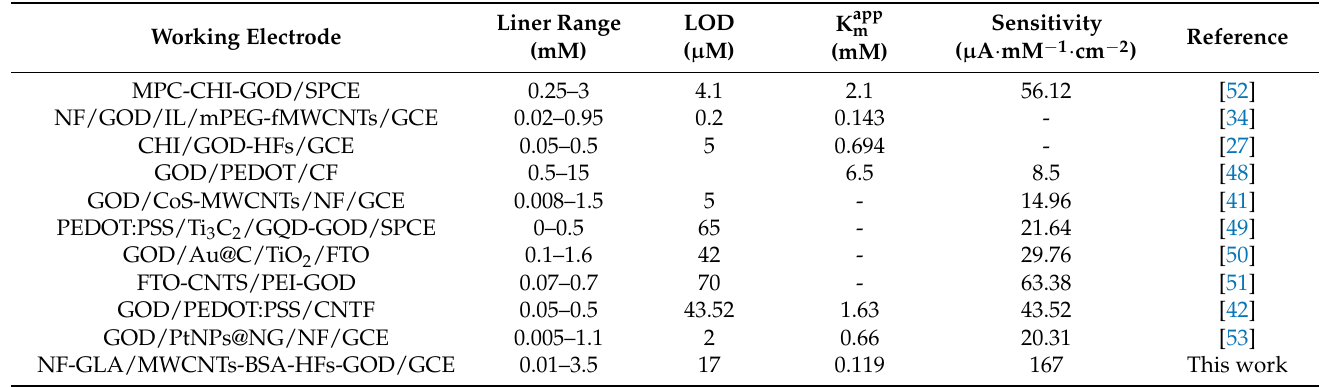
Table 3. Electrochemical parameters of the electrodes recently modified for Glu